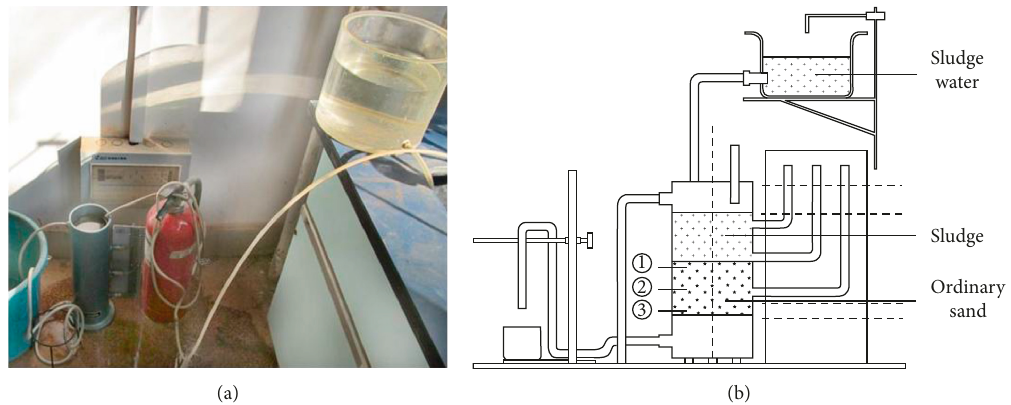
Figure 4: Experimental design for modeling the formation of organic sandy soil: (a) real product; (b)